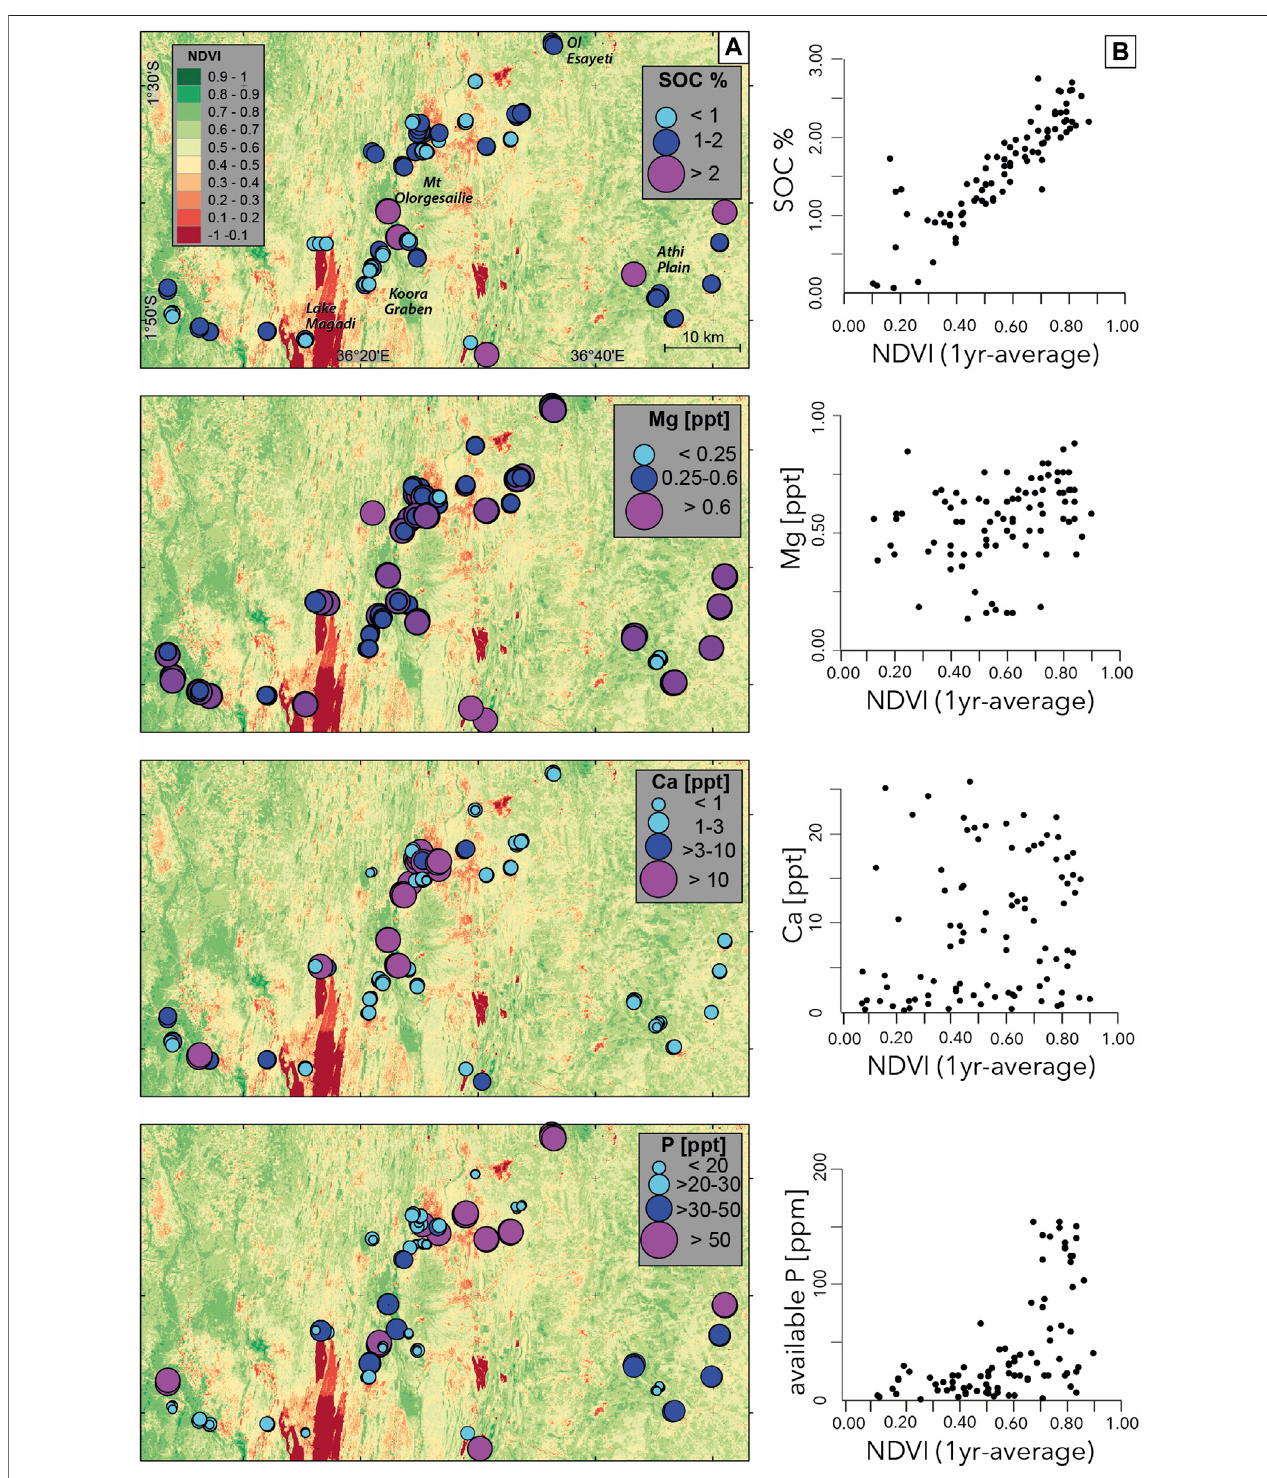
FIGURE 4 | SOC, NDVI and soil nutrient distributions; (A) variations in SOC and soil nutrient levels in topsoil samples of the study area, sample locations are representedbycoloredcircles,backroundmapshowsdistributionofhealthyvegetationusinga1-yearaverageNDVIdataset,derivedfromSentinel2data. (B) diagrams showing the relationship between SOC and soil nutrients vs. NDVI.